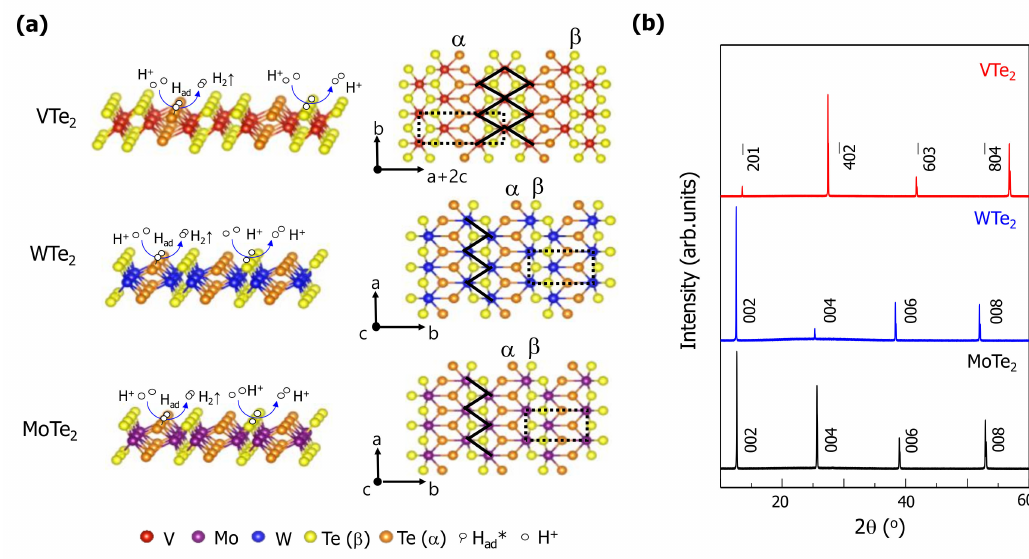
Figure 1. ( a ) Schematics of monolayer TM Te 2 (TM = V, W, and Mo) with side and top view. Protons (H + ) in acidic electrolyte (0.5 M H 2 SO 4 ) are just passing without reactions at catalytic inactive Te atoms ( β site, yellow circles), but are adsorbed at catalytic active Te atoms ( α site, orange circles) and subsequently are converted to hydrogen gas (H 2 ). (WTe 2 ; a = 3.498 Å and b = 6.338 Å, MoTe 2 ; a = 3.487 Å and b = 6.366 Å, VTe 2 ; b = 3.605 Å, a + 2c = 9.529 Å). ( b ) X-ray di ff raction of three TM Te 2 single